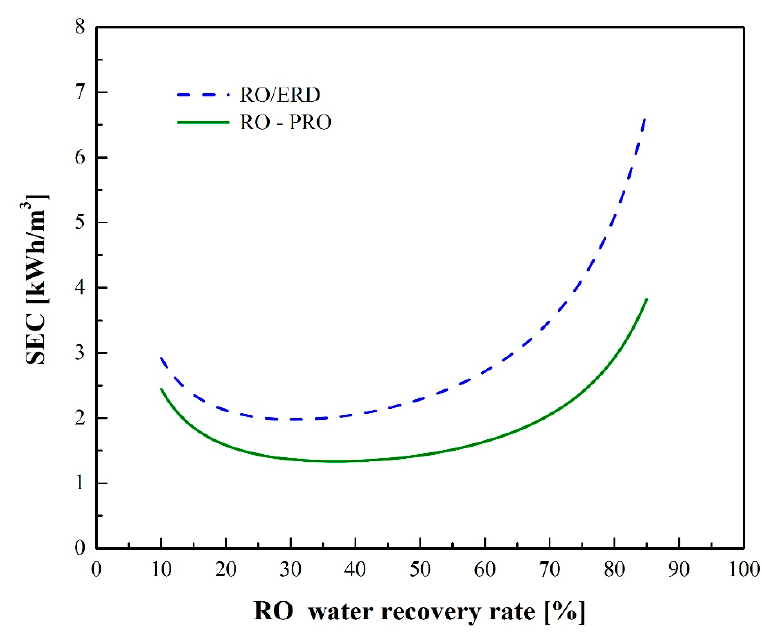
Figure 8. Simulation results of SE for CRO-ERD and RO-PRO at different water recovery rates.